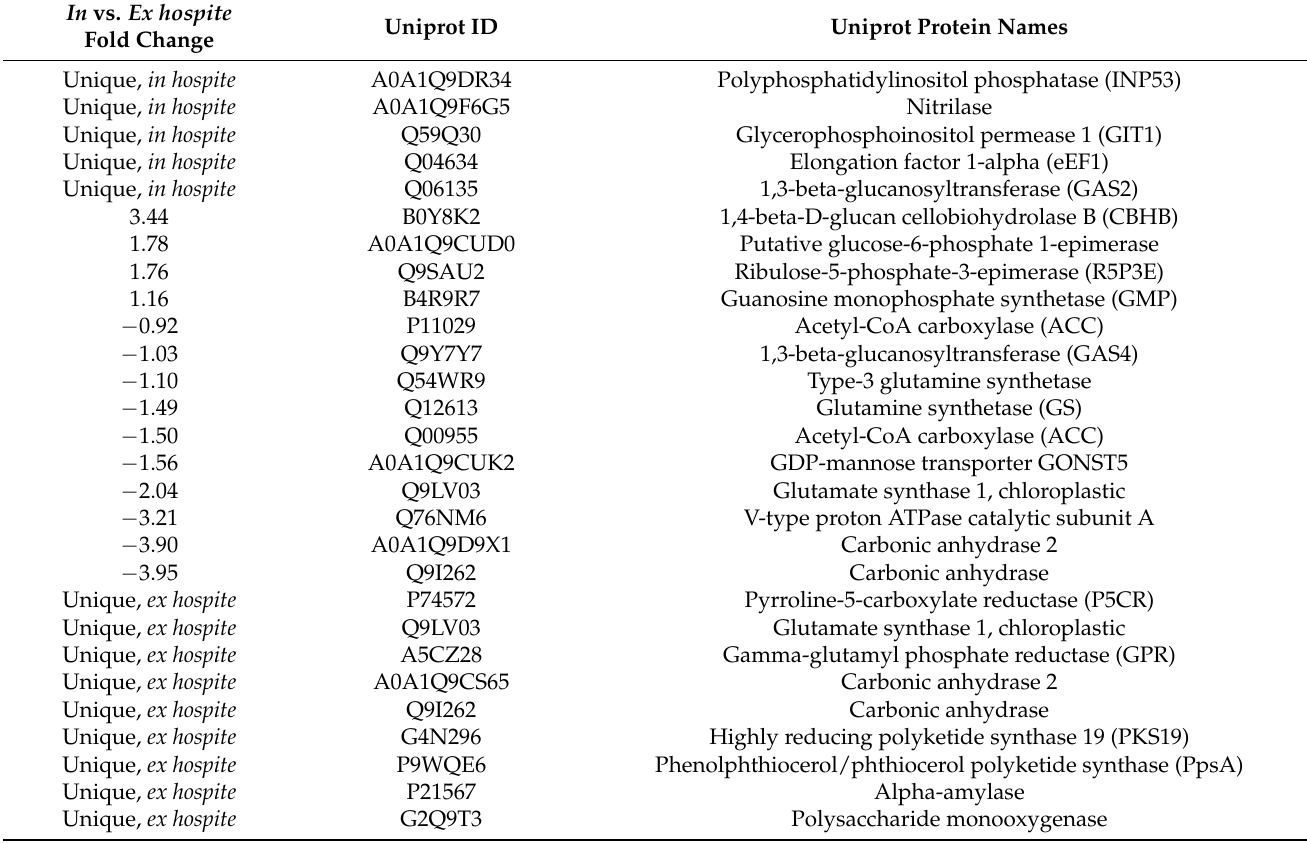
Table 1. Summary of proteins that are differentially abundant (FDR < 0.05) in Breviolum minutum when comparing in hospite vs. ex hospite , in order of log 2 fold-change. Proteins shown are those discussed in the text. The full list of proteins that are differentially expressed in hospite vs. ex hospite is available in Table